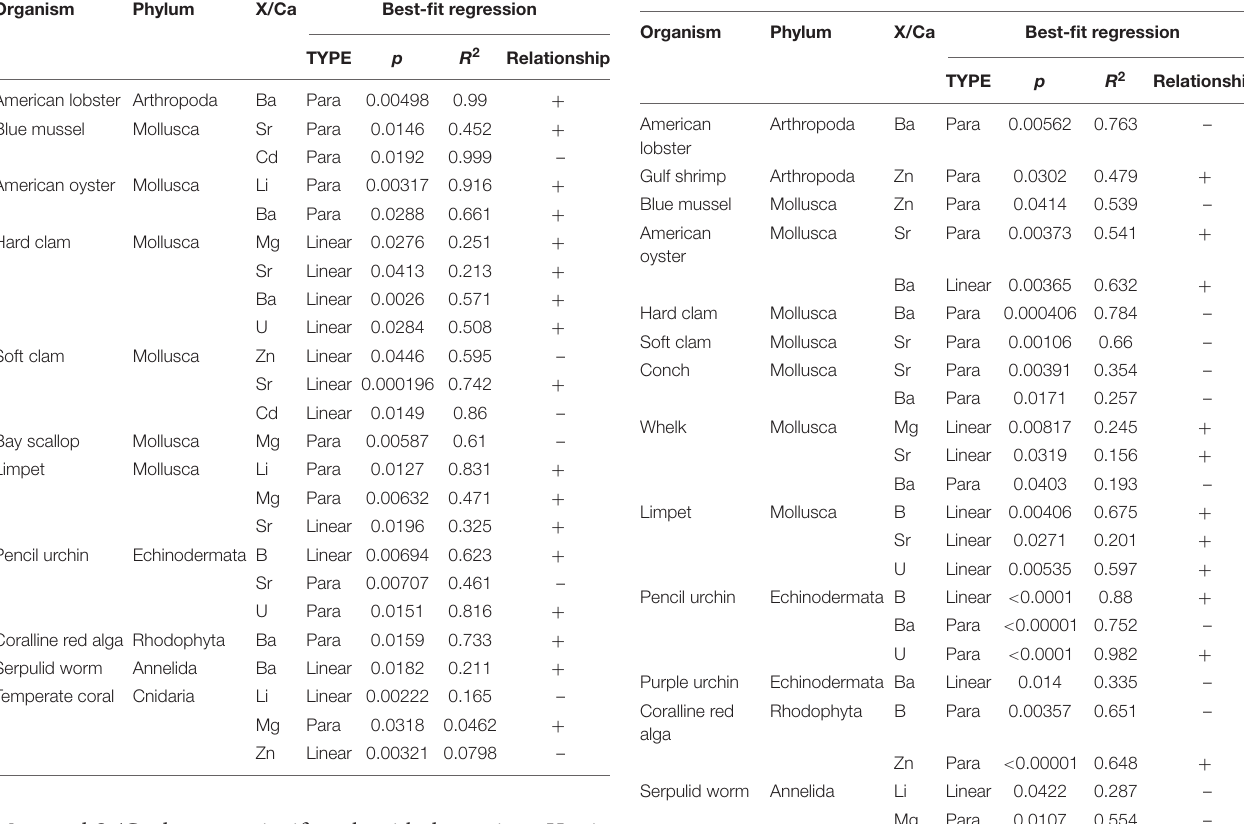
TABLE 4 | Summary of AIC test results for significant relationships ( p < 0.05) between element/Ca ratios and seawater carbonate ion concentrations across all